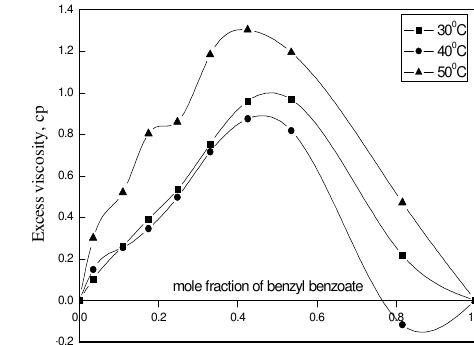
Figure 2c. Variation of excess internal pressure with mole fraction of benzyl benzoate in the mixture benzyl benzoate + benzonitrile